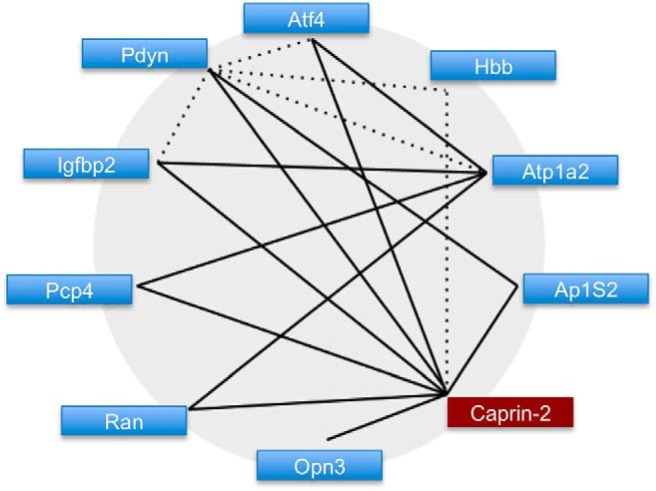
The validated Glasso-derived gene network. Link with significant Pearson correlation (p < 0.05) are represented by solid lines. Links not significantly correlated are represented by dotted lines.